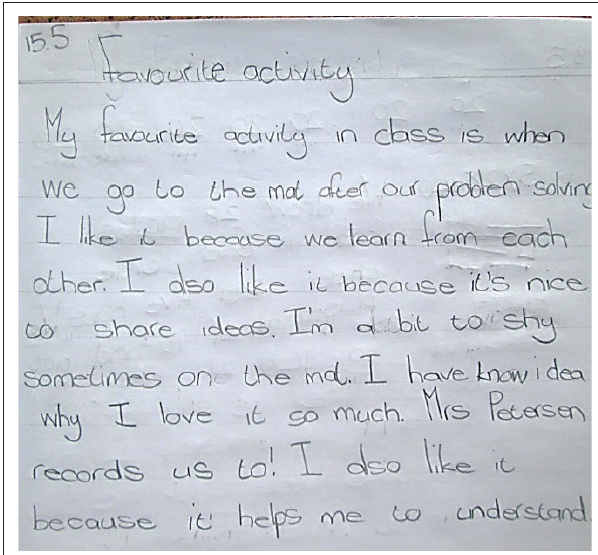
FIGURE 3: Gemma (Thinking and learning processes).